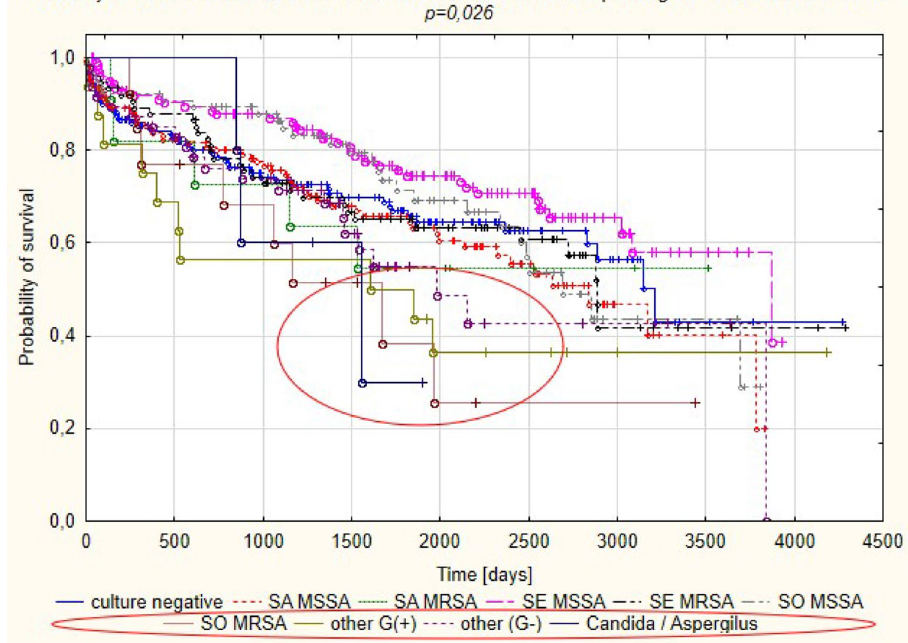
Figure 4. Probability of survival in patients with LRIE depending on pathogen type.